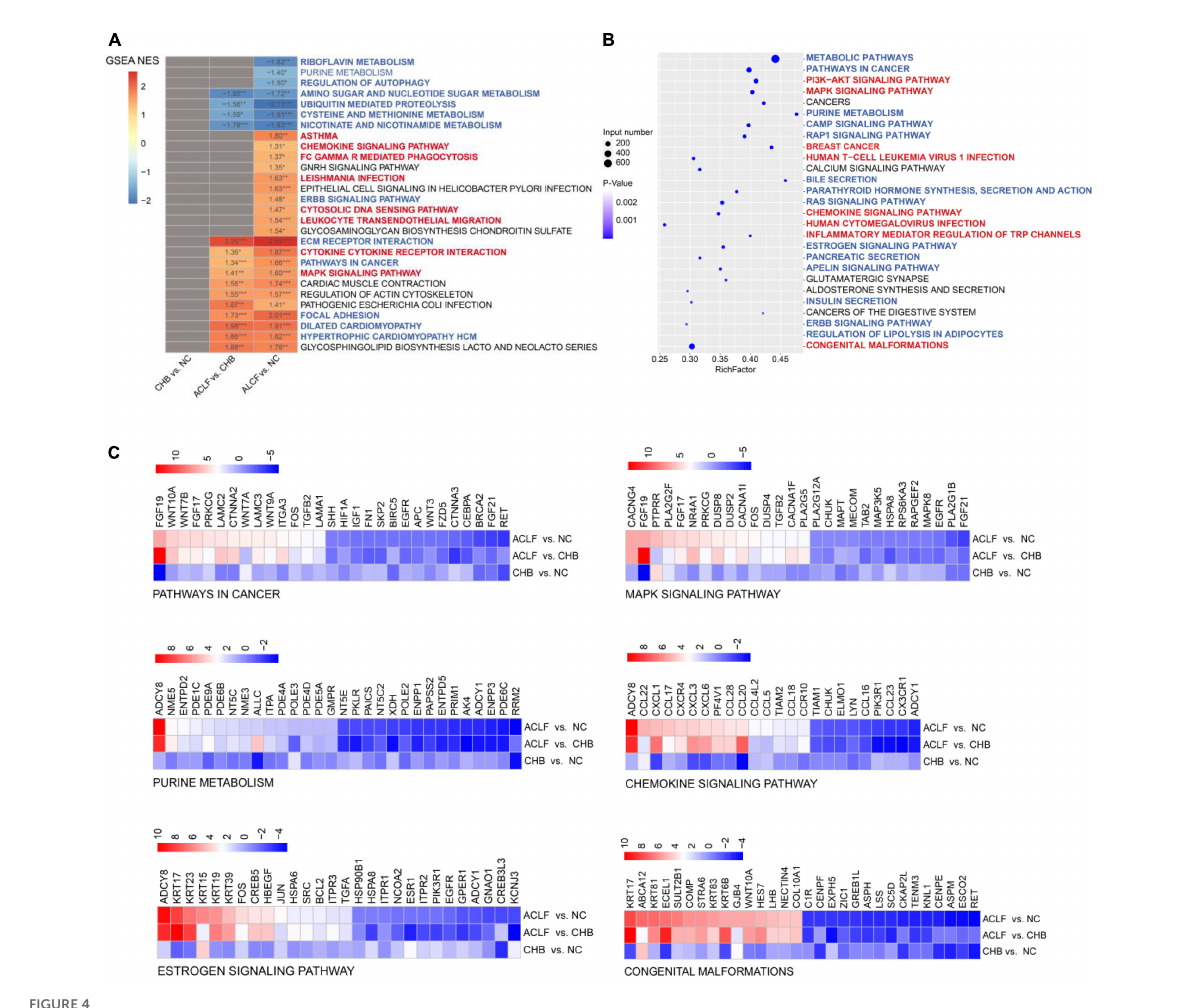
FIGURE4 Immunometabolic pathways (containing the three target genes) were significantly altered in the development of ACLF. (A) Enrichment analysis was performed using GSEA, with the red and blue numbers indicating the normalized enrichment score for each gene set. The color intensity is proportional to the NES calculated using GSEA. Immunometabolic pathways were significantly altered during the development of ACLF, based on the enriched KEGG pathways. Blue and red highlighting indicate metabolic and immune pathways, respectively. (B) Bubble plot of the three target genes significantly associated with the 27 immunometabolic KEGG pathways, with blue and red highlighting indicating metabolic and immune pathways, respectively. (C) Heatmap of three specific biomarkers from the selected immunometabolic pathways. The top 30 DEGs in each pathway (adjusted p value < 0.05) are shown. Genes ranked less than 30 are shown completely. Genes with higher (red) or lower (blue) expression are shown proportionally. ACLF, acute-on-chronic liver failure; HBV, hepatitis B virus; CHB, chronic hepatitis B; NC, normal control; GSEA, gene set enrichment analysis; NES, normalized enrichment score; KEGG, Kyoto Encyclopedia of Genes and